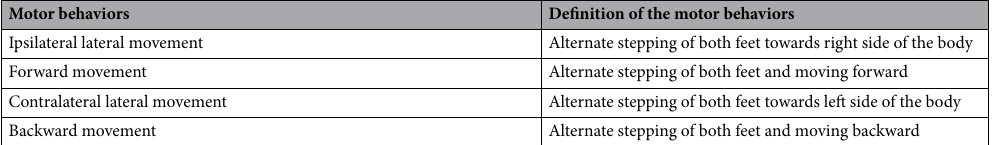
Table 2. Definitions of some motor behaviors in the arena. The number of steps generated by different behaviors is generally 2–3.